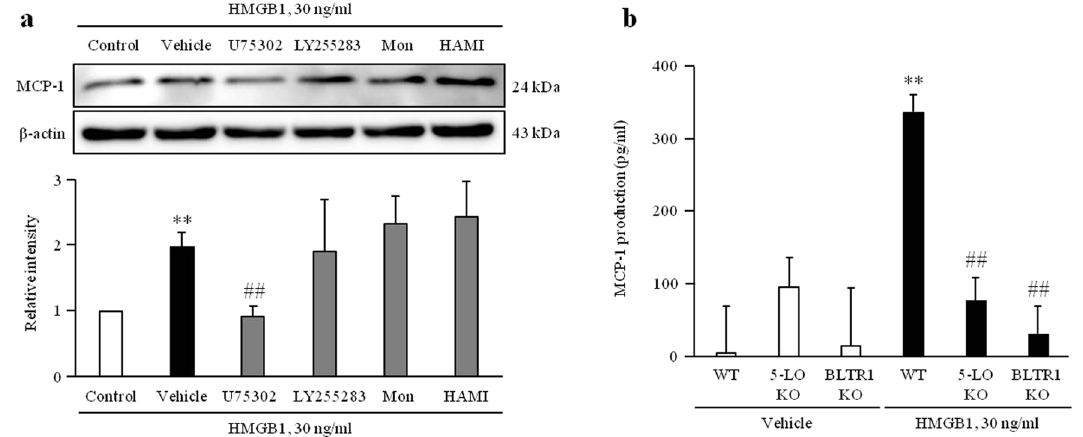
Figure 6. An essential role of BLTR1 on HMGB1-induced MCP-1 production and expression in VSMCs. ( a ) VSMCs were pretreated with U75302 (10 μM), LY255283 (10 μM), montelukast (1 μM) and HAMI3379 (10 μM) for 1 h, and then stimulated with HMGB1 (30 ng/ml) for 48 h. The expression of MCP-1 was determined by Western blotting using β-actin as an internal control. Results were expressed as the mean ± SEM of 4 independent experiments. ** p < 0.01 vs. control and ## p < 0.01 vs vehicle. Image analysis was performed using the Amersham-Imager 680, ver. 2.0. software (https:// www. cytiv alife scien ces. com/). Cropped gels were displayed and full-length blots/gels are presented in supplementary Fig. S6. ( b ) VSMCs cultured from thoracic aorta of WT, 5-LO- and BLTR1-KO mice were treated with HMGB1 (30 ng/ml) for 48 h. MCP-1 production was measured in the cell culture media, and results were expressed as the mean ± SEM of 3 independent experiments. ** p < 0.01 vs. corresponding value in Vehicle and ## p < 0.01 vs WT in HMGB1 group. Signal was quantified with GraphPad Prism 5, ver. 5.01. software (https:// www. graph pad.